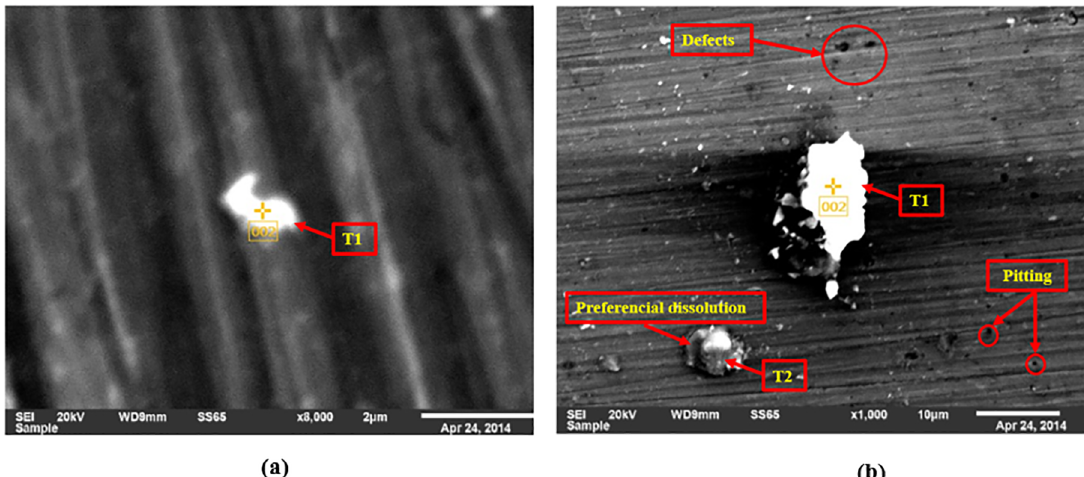
Figure 4. (a) SEM observation of the AA2524-T3 aluminium alloy after the open circuit potential tests and (b) SEM observation of the AA2524-T3 aluminium alloy after the potentiodynamic polarization tests.